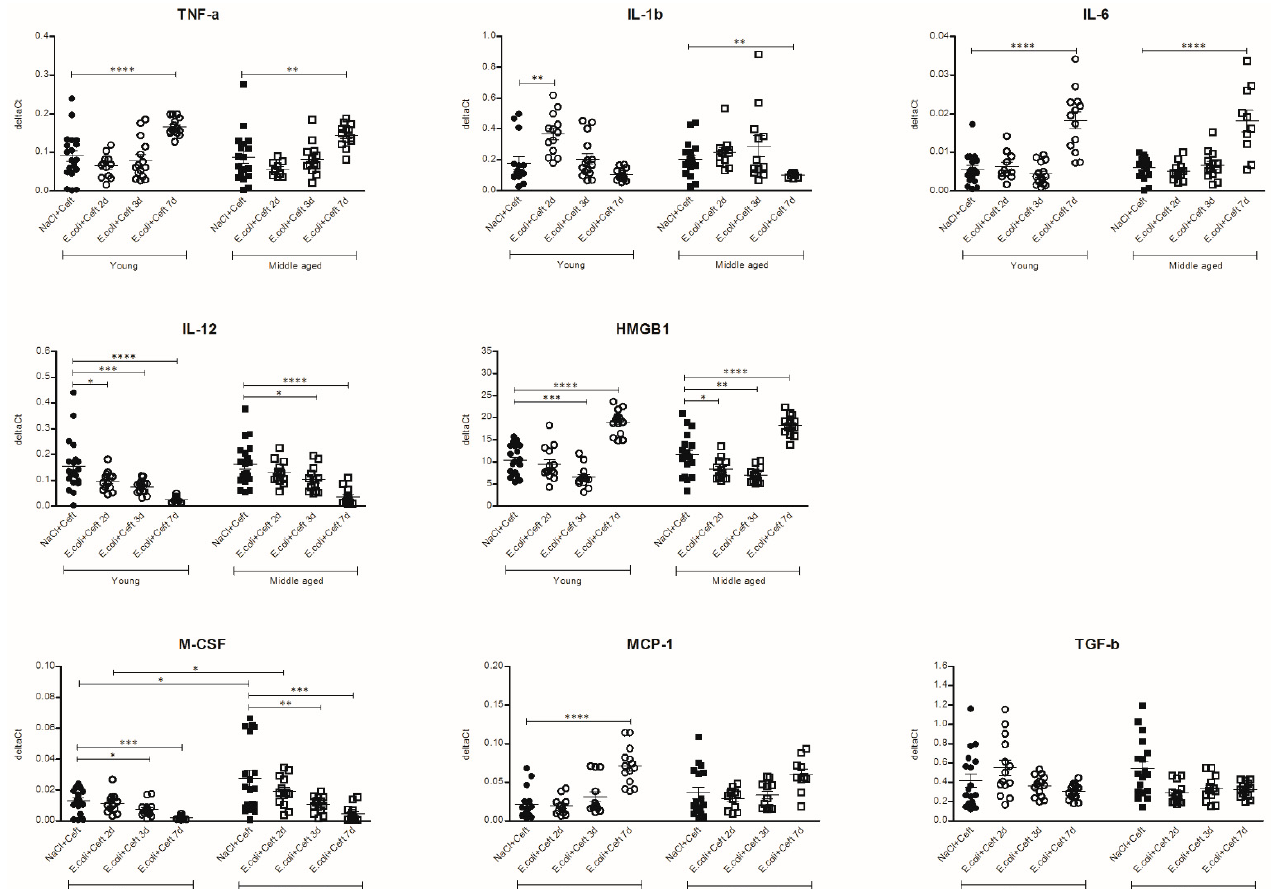
Figure 10. mRNA expression of spleen homogenates of TNF- α , IL-1 β , IL-6, IL-12, HMGB1, M-CSF, MCP-1, and TGF- β , illustrated in deltaCts. Group size varies from n = 10 to 15. Parametric or non-parametric two-way ANOVA (factors: age and time point) were conducted and continuous variables were tested with post-hoc Mann–Whitney U tests or Student t -tests, depending on the distribution of the data. For non-parametric ANOVAs, ranked transformation of the data was performed. Data represent mean ± SEM, * p ≤ 0.05, ** p ≤ 0.01, *** p ≤ 0.001, **** p ≤ 0.0001.